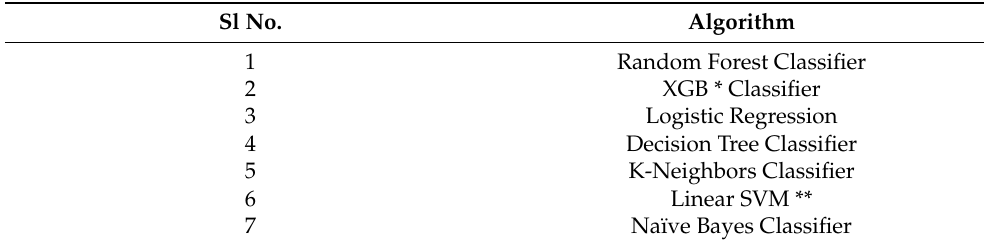
Table 3. Machine Learning algorithm models. Sl